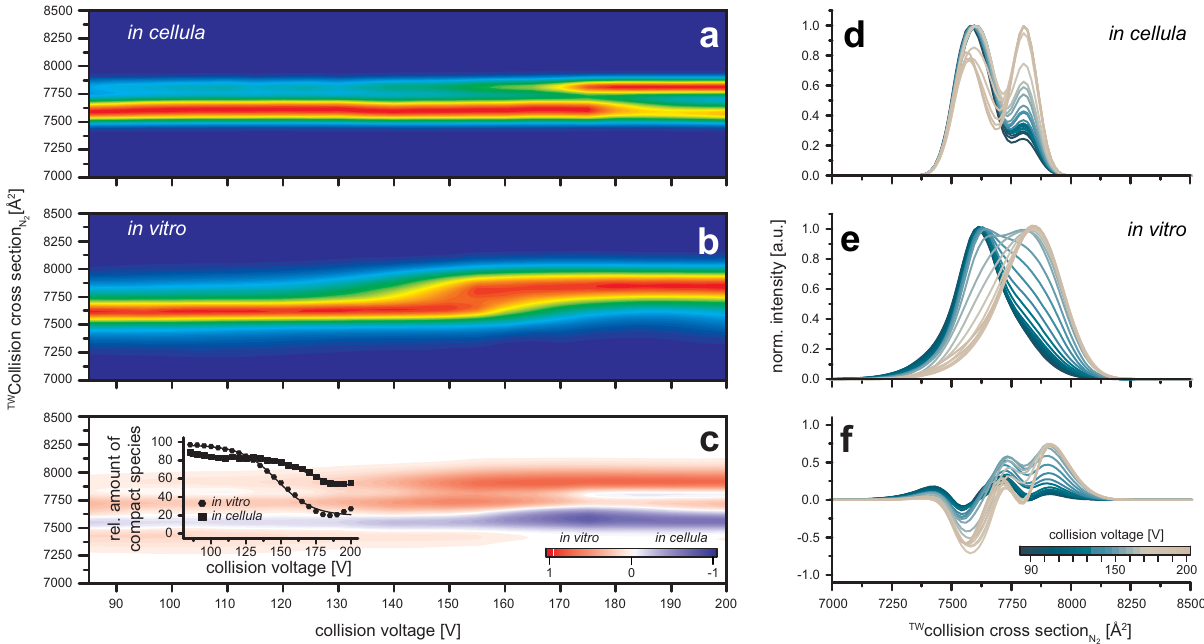
Fig. 10 CIU fi ngerprints of the in cellula and in vitro assembled αβ heterodimer in the presence of ATP and Mg 2 + . a In cellula assembled αβ heterodimer. b In vitro assembled αβ heterodimer. Exemplary spectra are shown in Supplementary Fig. 10. At low collision voltages the IM signal of the αβ heterodimer appears at 7595 Å 2 for the in cellula and at 7630 Å 2 for the in vitro assembled αβ heterodimer, respectively. At higher collision voltages the signal of the in vitro assembled αβ heterodimer unfolds, resulting in a signal at 7851 Å 2 . At 152.6 V 50% has reached the unfolded state. In contrast, increasing the collision voltage in the case of the in cellula formed αβ heterodimer leads to a signal appearing at 7802 Å 2 . 50% unfolding is never reached — the maximal unfolding of 47% is observed at 200 V. c The difference plot of both fi ngerprints illustrates the change regarding unfolding behavior between in vitro and in cellula assembled heterodimers. d – f CCS distribution for different collision voltages for in vitro ( d ) and in cellula ( e ) assembled heterodimers, and the difference plot ( f ). The overall feature of the in vitro αβ is clearly broader than for the in cellula αβ